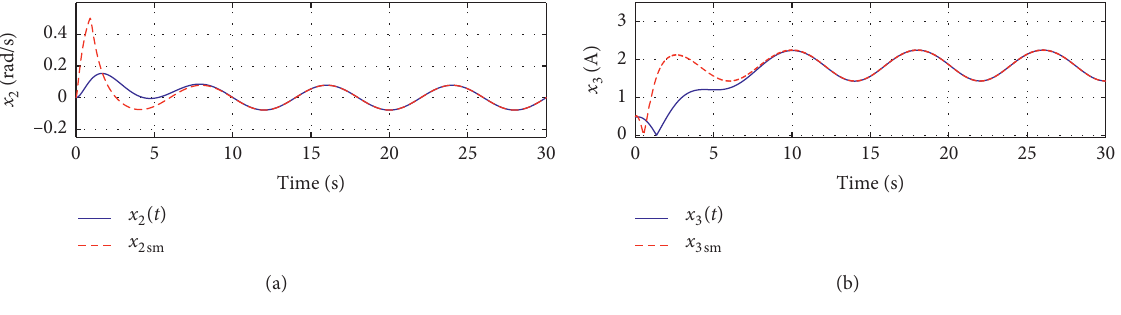
Figure 10: State behaviour (comparison test).